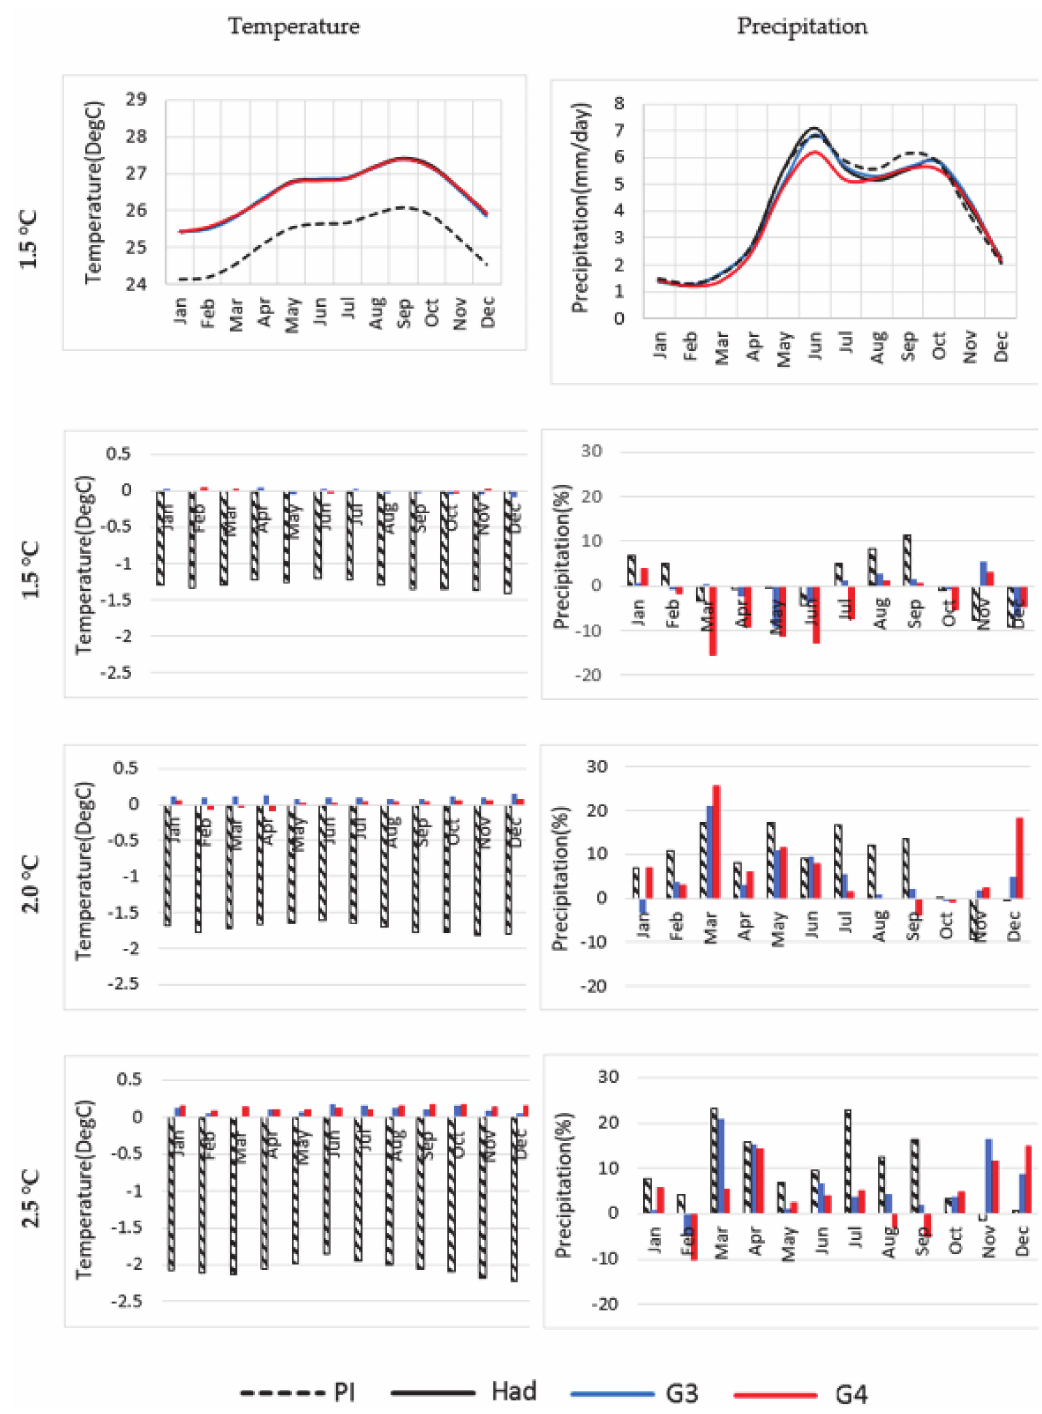
Figure 10. Row 1: Climatology plots of air temperature ( left panel) and precipitation ( right panel) for HadGEM_unaltered, G3 and G4 at 1.5 ◦ C, and for the preindustrial (PI) period (1860 to 1900). Rows 2 to 4: Differences between G3 (red), G4 (blue) and PI (hatched black) climatologies and HadGEM_unaltered climatology at 1.5, 2.0 and 2.5 ◦ C. Future climatologies were calculated for the 11-year period centered on when each experiment attained the respective LTTGs. Row 1 shows actual values, while rows 2 to 4 shows absolute and percentage